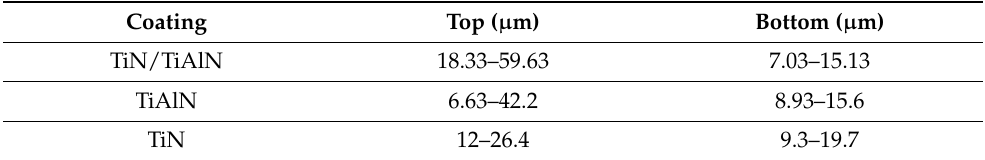
Table 7. Range of hole-circularity errors for each tool